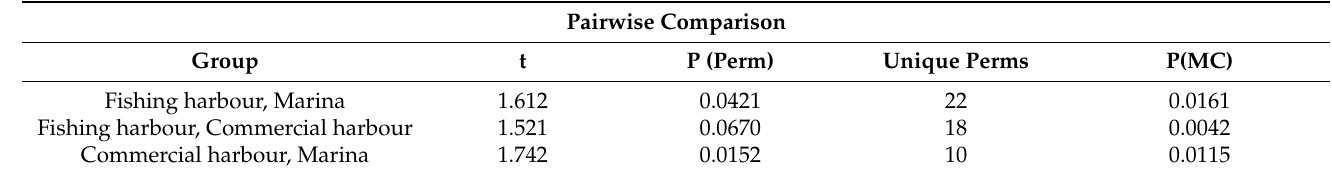
Table 3. Results from PERMANOVA using Bray–Curtis distance matrices to test differences between the three separate macrobenthic assemblages of the three harbours. Significant p -values are given in bold.